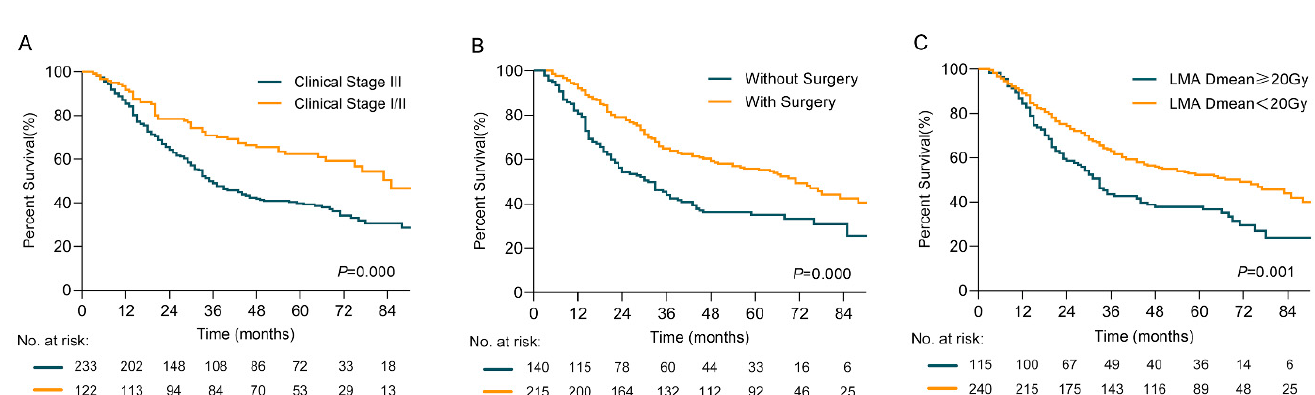
Figure 3. Overall survival rates ( A ) for patients with clinical stage I/II or III ( B ) for patients with or without surgery ( C ) for patients with 20 Gy mean left main coronary artery (LMA) dose cutoff.